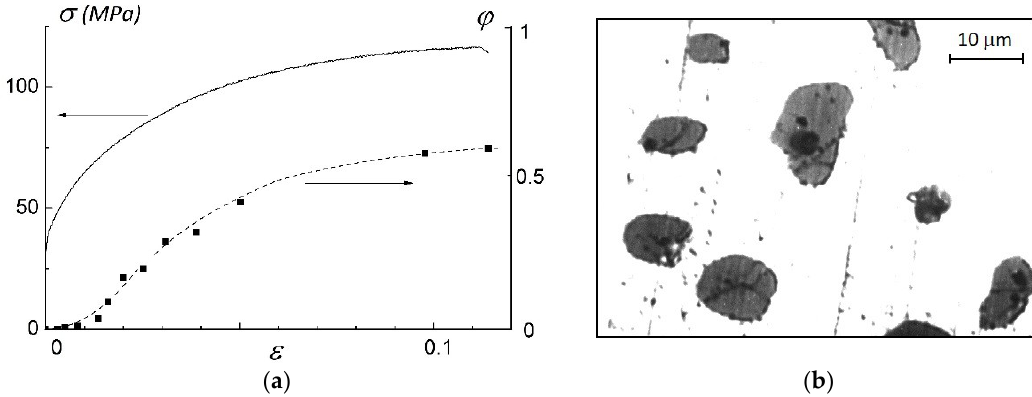
Figure 1. Deformation and damage properties at room temperature. ( a ) Example of an engineering stress-strain curve, σ ( ε ) and a typical strain dependence of the fraction ϕ of cracked particles. Squares show experimental data obtained using interrupted tests. The example of the entire deformation curve is given for another sample deformed without interruption until fracture. ( b ) Optical image of a section of the polished side surface of a deformed specimen.